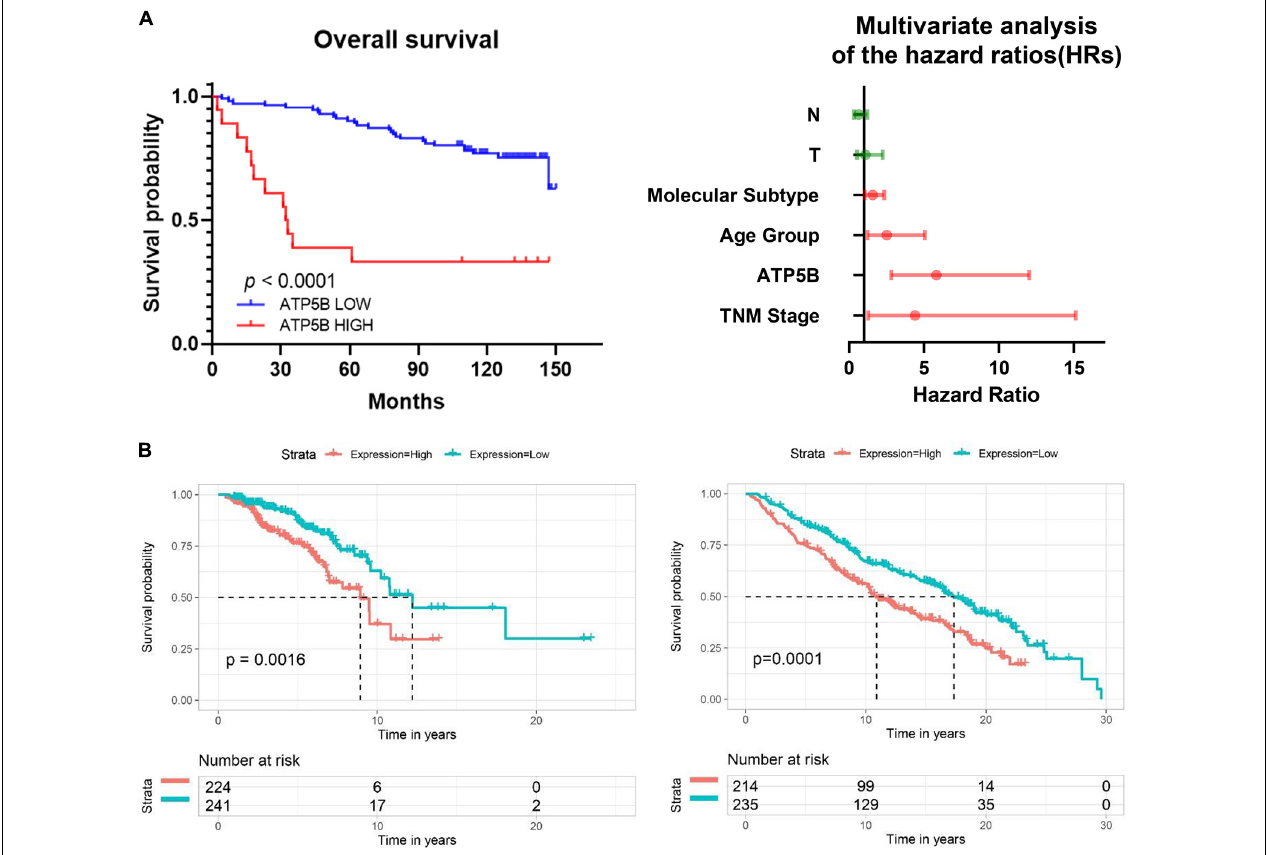
FIGURE 4 | Survival analysis of ATP5B based on clinical samples and online databases. (A) Kaplan-Meier (KM) survival curve comparing patients with high and low expression of ATP5B in TMA cohorts. Forest plot of multivariable Cox regression analysis shows that ATP5B is an independent risk factor for OS. Independent prognostic factors, including ATP5B expression and other clinical parameters, were evaluated using both univariate and multivariate Cox proportional hazards analyses. The HRs are presented as the median with 95% confidence interval. Red indicates the significant differences ( p < 0.05). (B) Overall survival of ATP5B based on the TCGA (total 1096 breast cancer samples, left) and the METABRIC (total 1904 breast cancer samples, right)